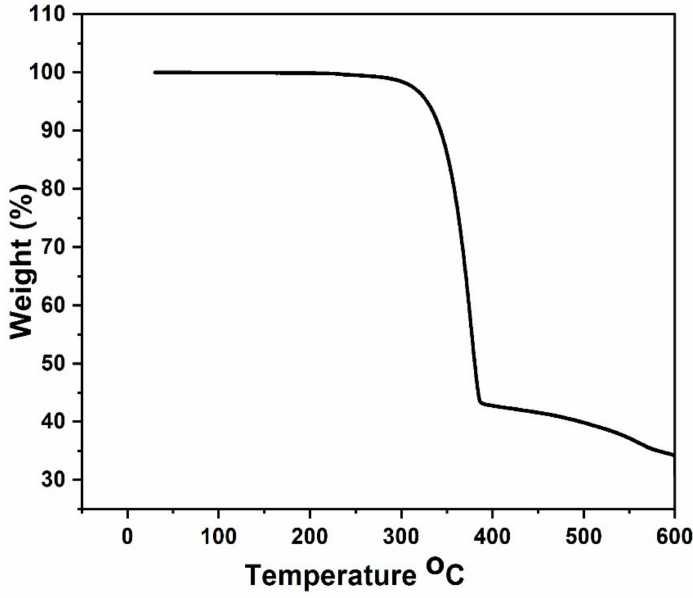
Figure 1. Thermogravimetric runs of the lead (II) diphenyldiselenophosphinate complex. The X-ray diffraction (XRD) spectra of prepared PbSe were acquired using Cu-K α , an X-ray source having a voltage of about 40 kV with a current supply of 30 mA. The pure cubic phase was indexed by diffraction peaks for both PbSe samples [46] obtained at 400 and 450 ◦ C, JCPD no. 03-065-0693 and 03-065-2941. The absence of additional peaks